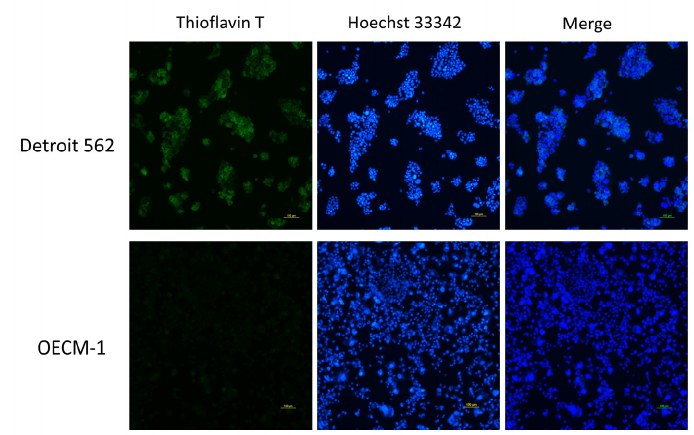
Figure 4. p53 is colocalized with thioflavin T in Detroit 562 cells. ( A ) p53 was used to stain for protein aggregation and is shown in red; thioflavin T was used to stain for protein aggregation and is shown in green; Hoechst 33342 was used to stain for nuclear counterstains and is shown in blue. p53 signals are shown to have the same location as the thioflavin T signals in the merged figure. ( B ) The merged figure shows that there are some cells with cytosolic thioflavin T/p53 signals (arrows).